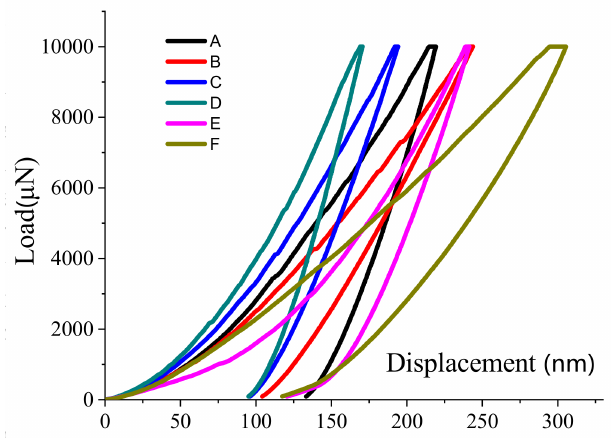
Figure 20. Load–displacement curves in bright-white